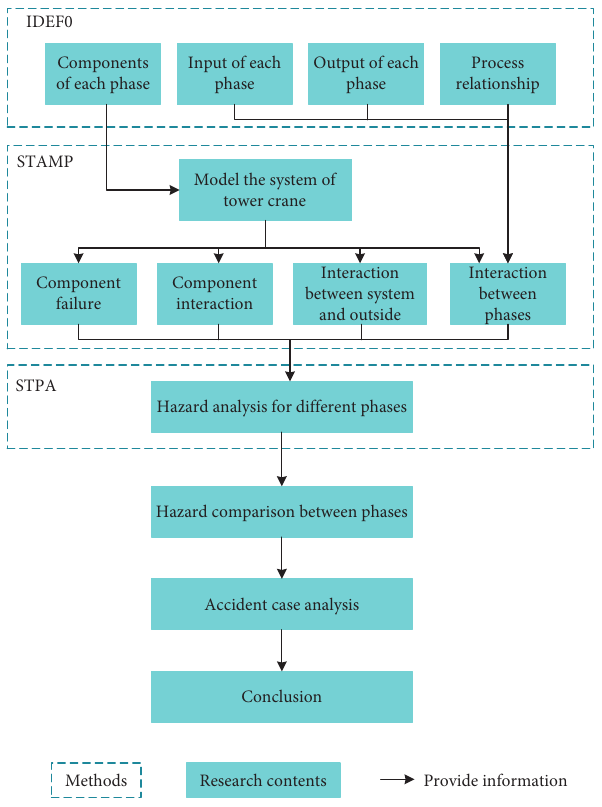
Figure 1: Research